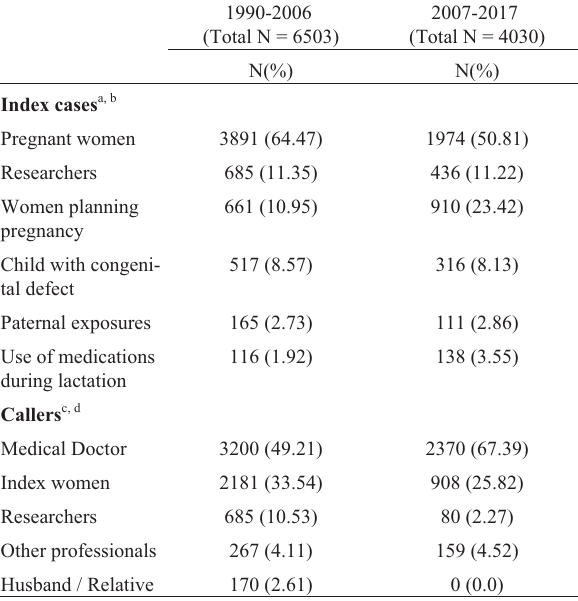
Table 1 - Profile of index cases and callers in the two different periods.